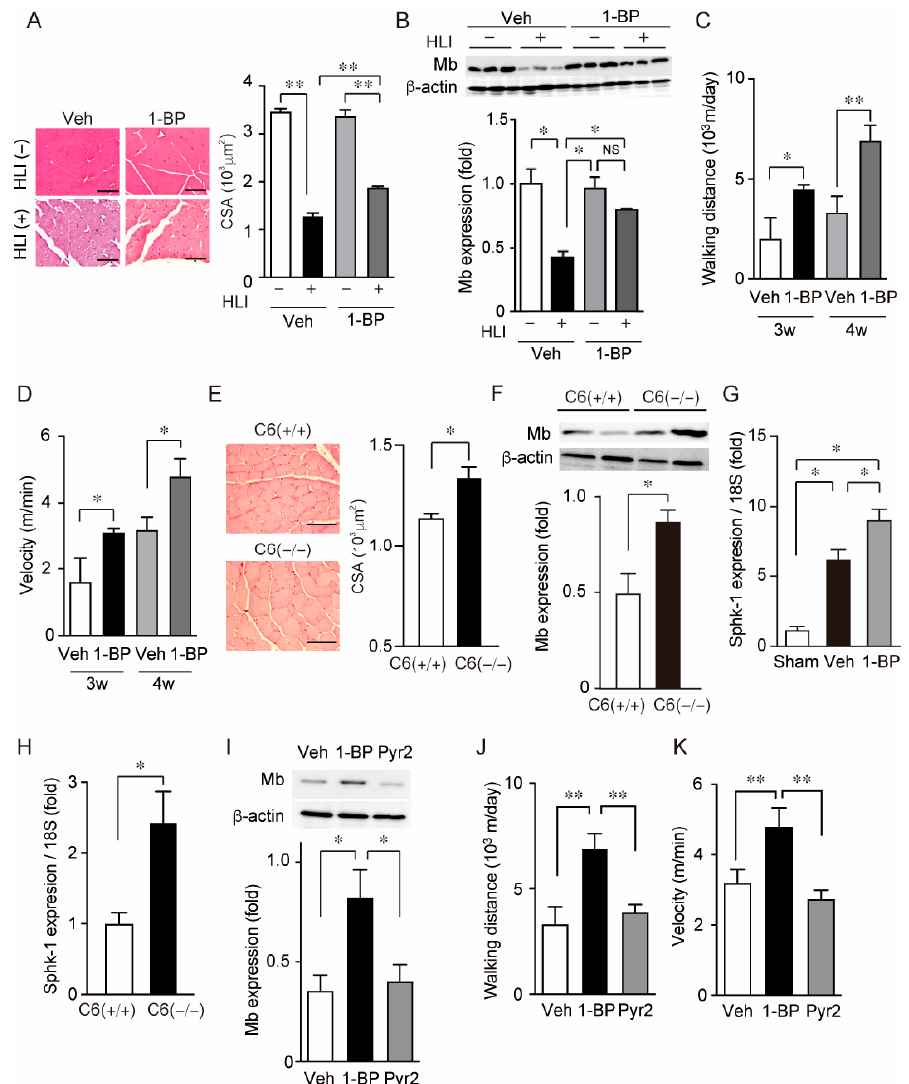
Figure 6. 1-BP treatment preserves skeletal muscle and motor function after HLI. ( A ) Representative images of H&E staining of gastrocnemius (left). Quantification of CSA of gastrocnemius muscle fibers 3 weeks after HLI (n = 4 mice). Scale bars: 100 µm. ( B ) Representative western blots and quantification of myoglobin (Mb) abundance in gastrocnemius muscle 4 weeks after HLI (n = 3 mice). ( C , D ) Motor activities analyzed by averaged walking distance ( C ) and velocity ( D ) during 24 h (n = 3 mice). ( E ) Representative images of H&E staining of gastrocnemius (left). Quantification of CSA of gastrocnemius muscle fibers 3 weeks in either WT (C6 (+/+)) or TRPC6 deficient (C6( − / − )) mice after HLI (n = 4 mice). Scale bars: 100 µ m. ( F ) Representative western blots and quantification of myoglobin (Mb) abundance in gastrocnemius muscle of either C6(+/+) or C6( − / − ) mice 4 weeks after HLI (n = 5 mice). ( G , H ) Relative mRNA levels of Sphk-1 in gastrocnemius muscle 2 weeks after HLI in each compound treated mice ( G ) (n = 4 mice) and in either C6(+/+) or C6( − / − ) mice ( H ) (n = 4 mice). ( I ) Representative western blots and quantification of Mb abundance in gastrocnemius muscle treated with either vehicle, 1-BP, or Pyr2 4 weeks after HLI. (n = 3 mice). ( J , K ) Motor activities analyzed by averaged walking distance ( J ) and velocity ( K ) for 24 h. (n = 6–11 mice). Data are median with 95% CI ( A – I ) or mean ± s.e.m. ( J , K ). * p < 0.05, ** p < 0.01. Comparisons were made using Kruskal-Wallis test ( A , B , G , I ), Mann-Whitney U -test ( C – F , H ) or One-way ANOVA followed by Tukey’s multiple comparison tests ( J , K